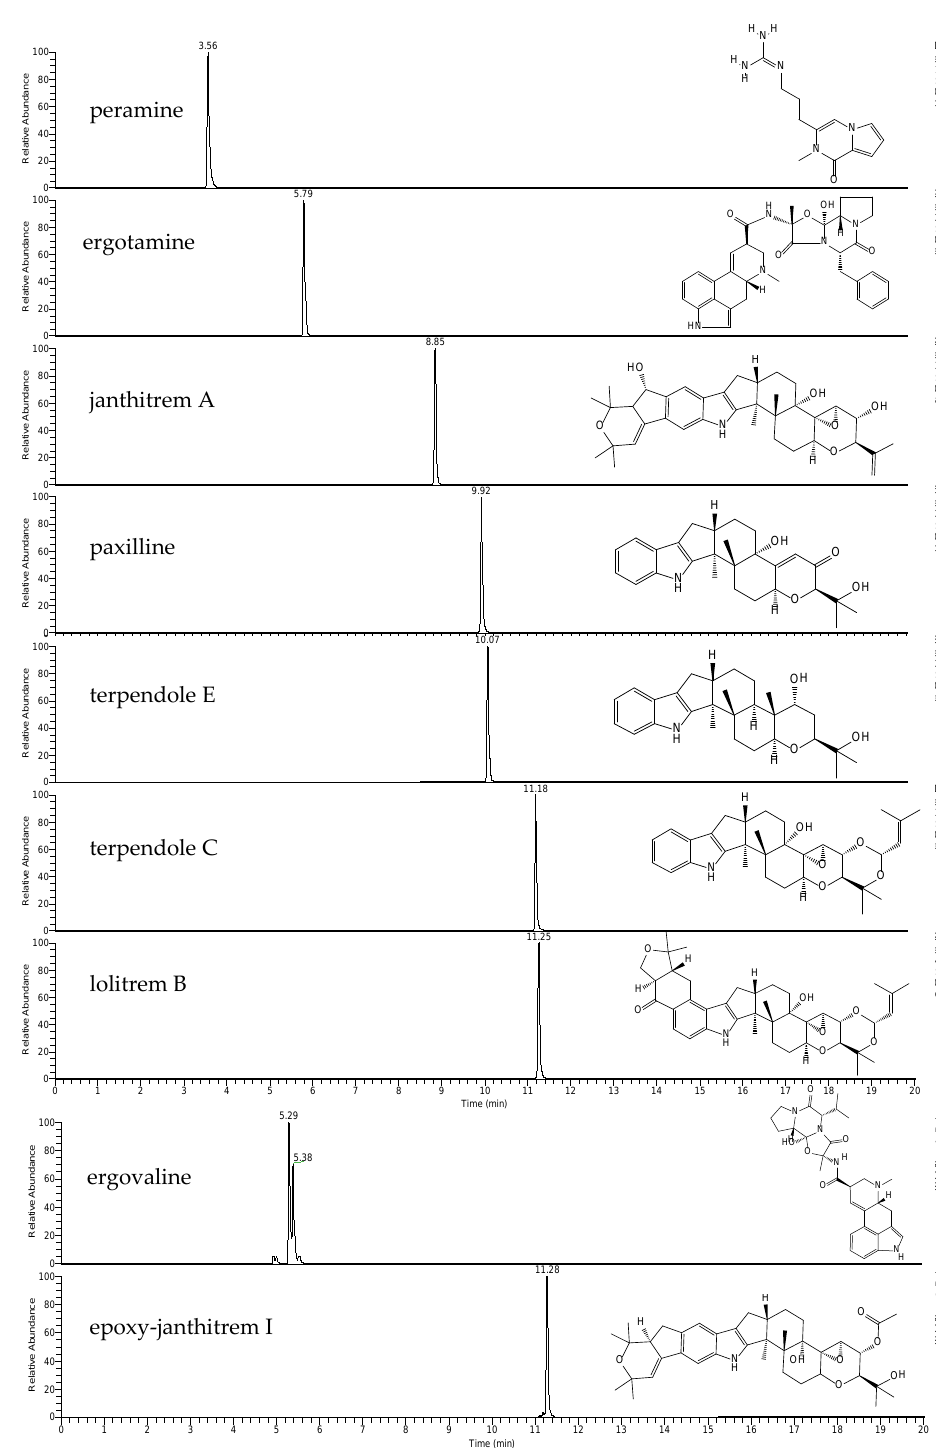
96.7% for terpendole C 2 (the fragment ion) at the low concentration resulted, well within the limit suggested by Peters et al. [36].